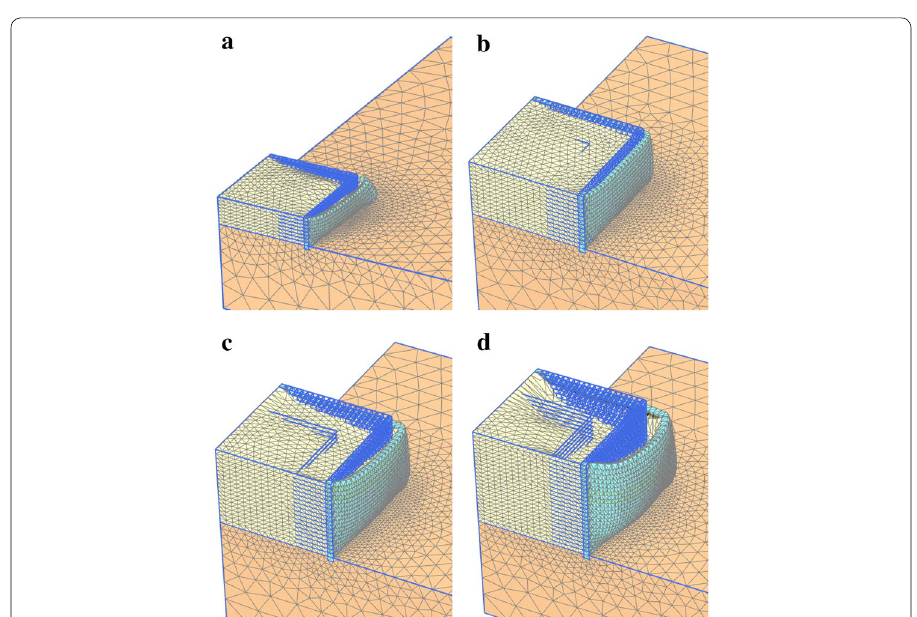
Fig. 8 Deformed meshes: a CASE 1; b CASE 2; c CASE 3; d CASE